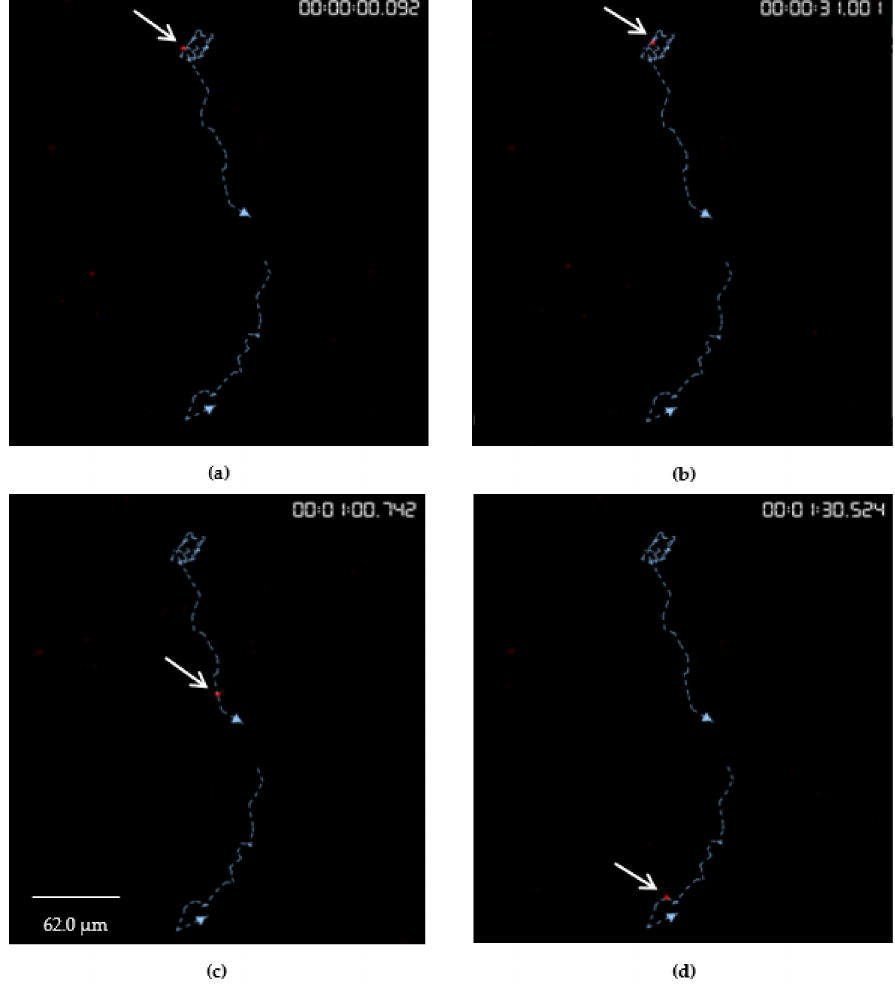
Figure 5. Nile red-stained zoospores of Spizellomyces sp. collected from cultures grown on 5 mM phosphate at 8 weeks. Four image sequences over the course of 1.5 min with 1 s intervals ( a – d ).